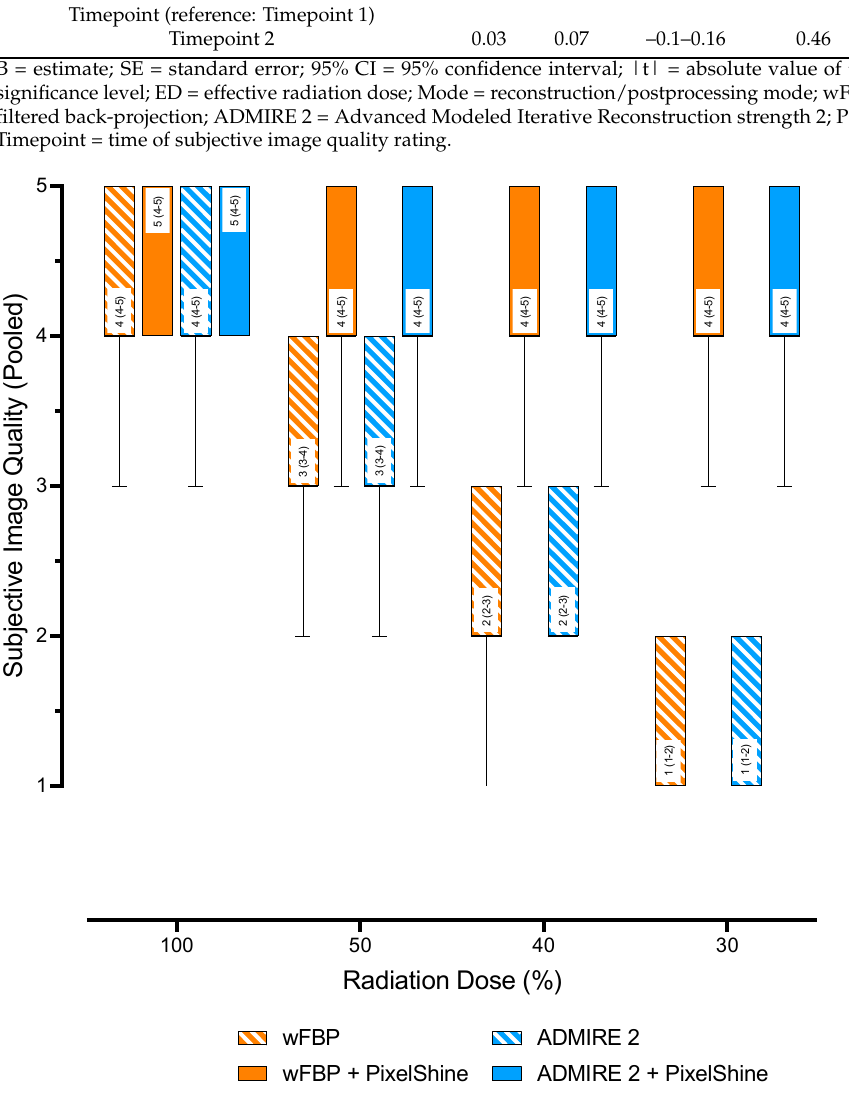
Figure 2. Pooled subjective image quality scores. wFBP = weighted Filtered Back Projection, ADMIRE 2 = Advanced Modeled Iterative Reconstruction strength 2.